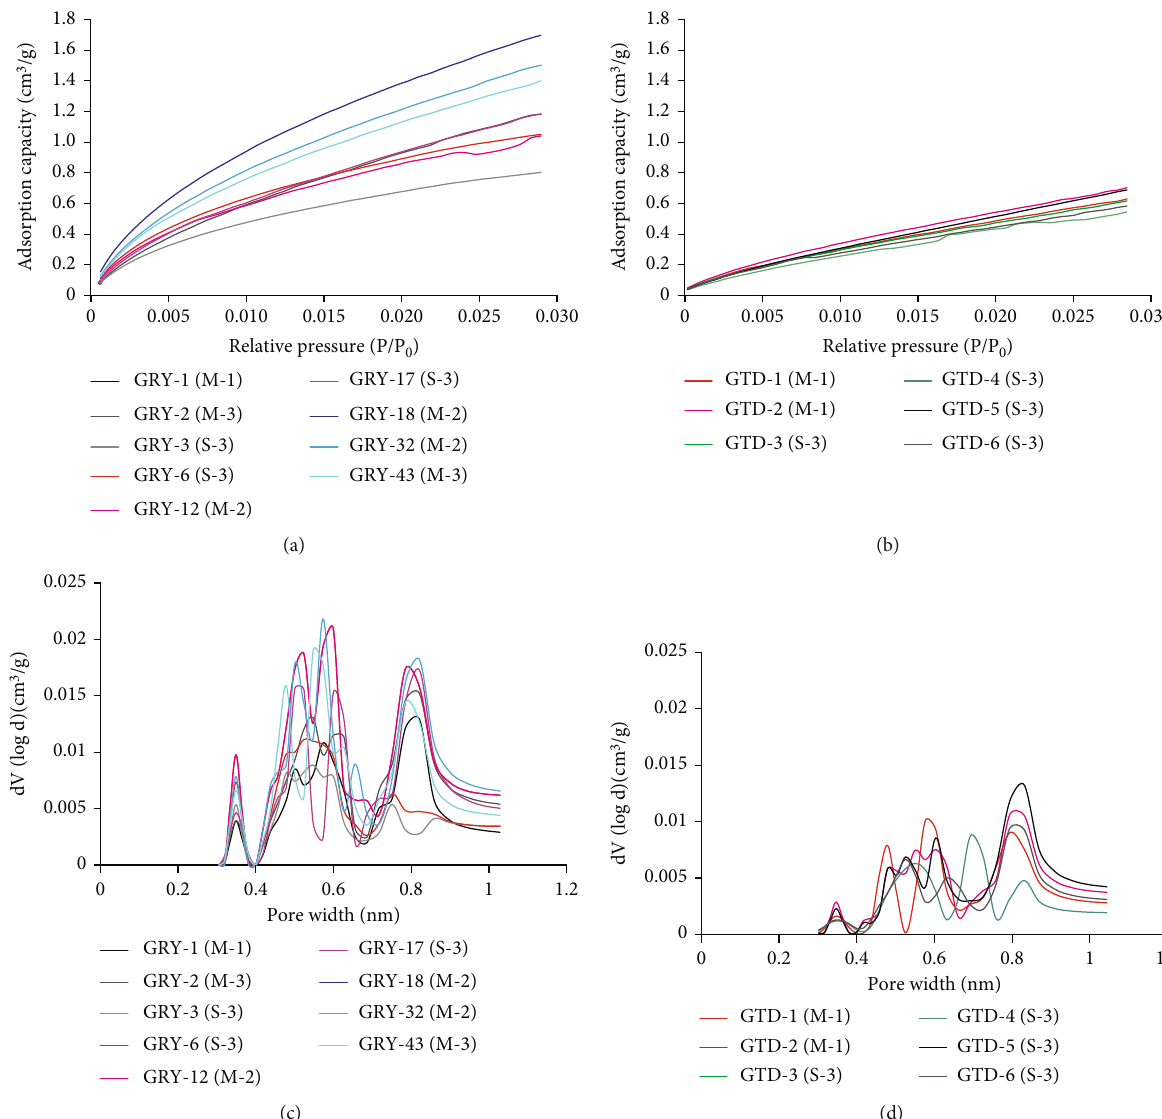
Figure 5: (a) CO adsorption curve of Carboniferous shale samples in well GRY1; (b) CO 2 pore diameter distribution curve of Carboniferous shale samples in well GRY1; (d) CO well GTD1; (c) CO 2 curve of Devonian shale samples in well